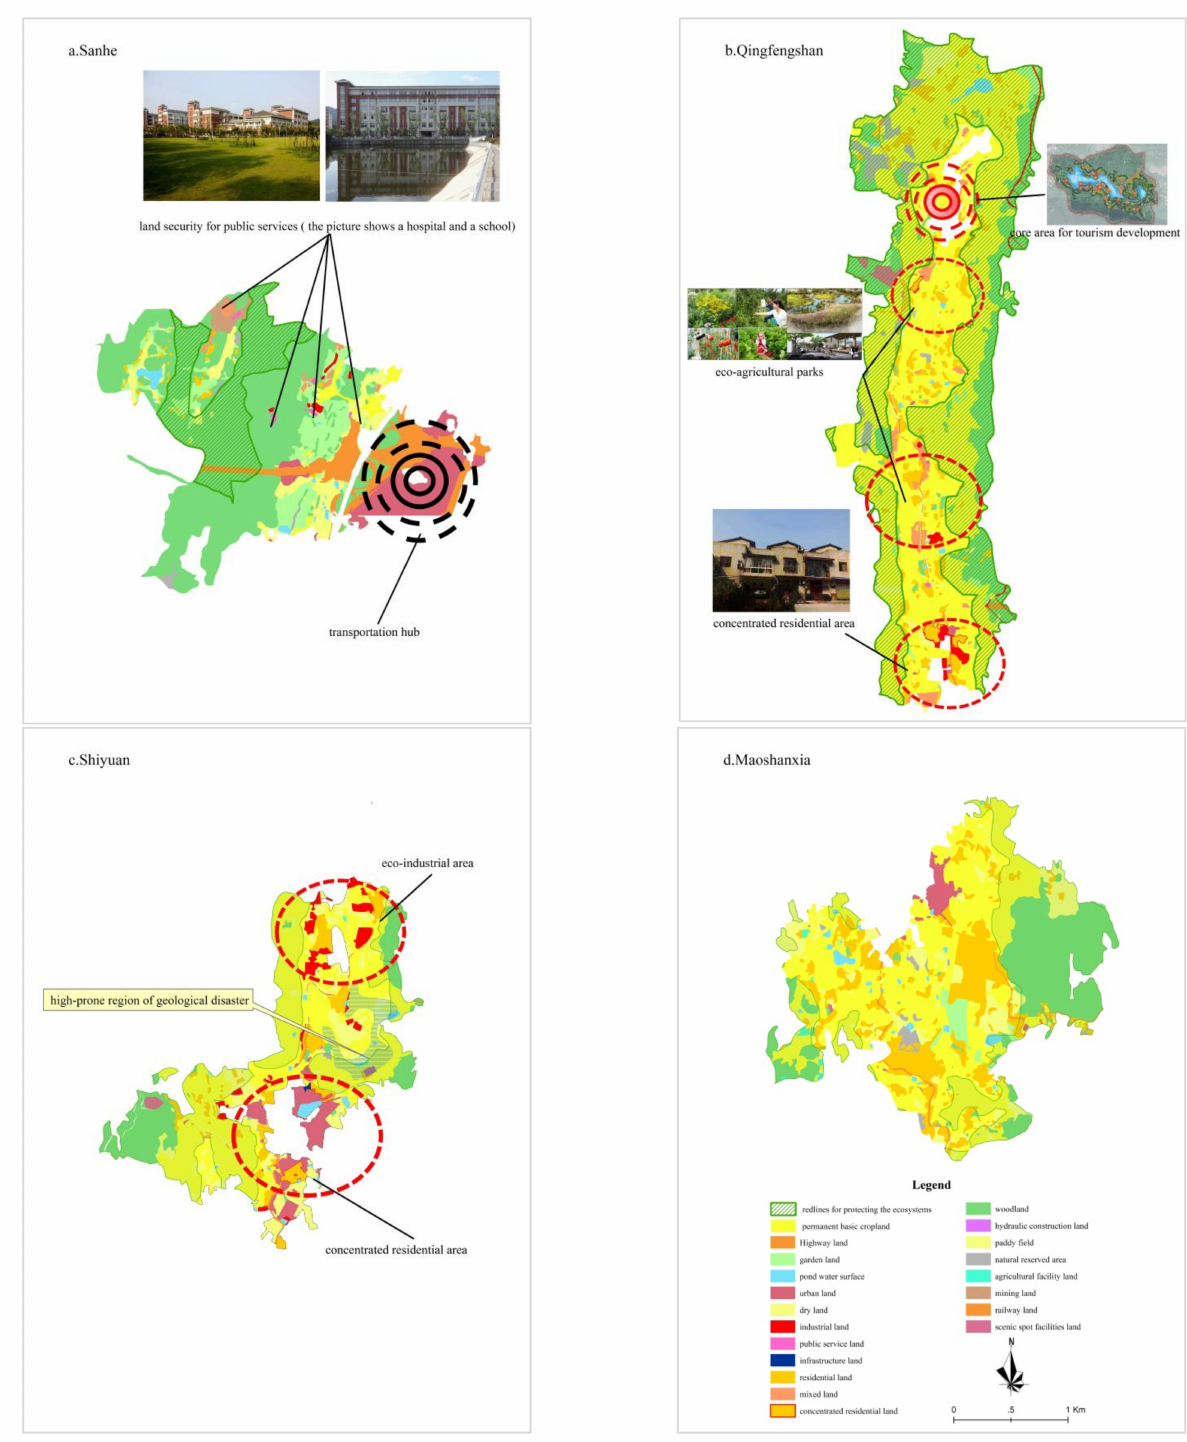
Figure 6. Land use layout planning for different types of